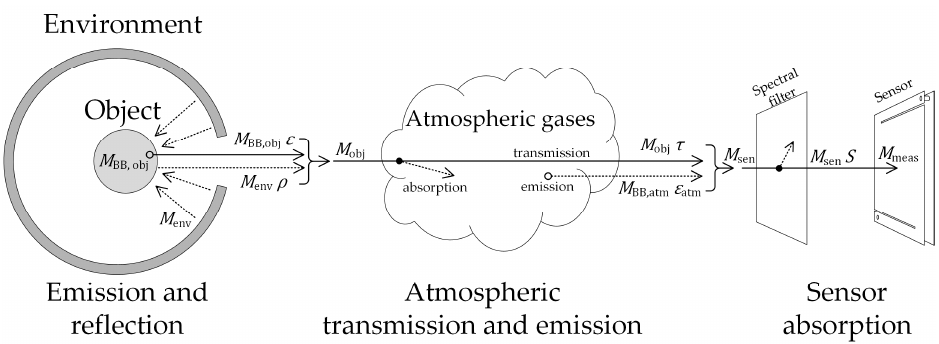
Figure 1. Physical system of measurement in radiation thermometry with key influence parameters. Physical quantities and their notation correspond to Equation (3) .